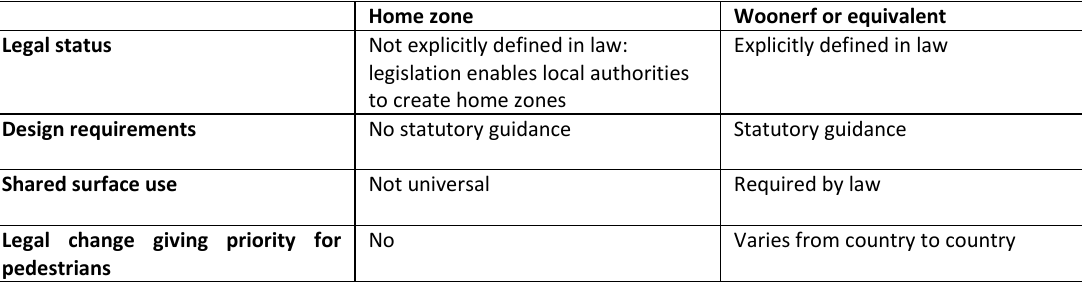
Table 1 The home zone vs. the woonerf (Gill,